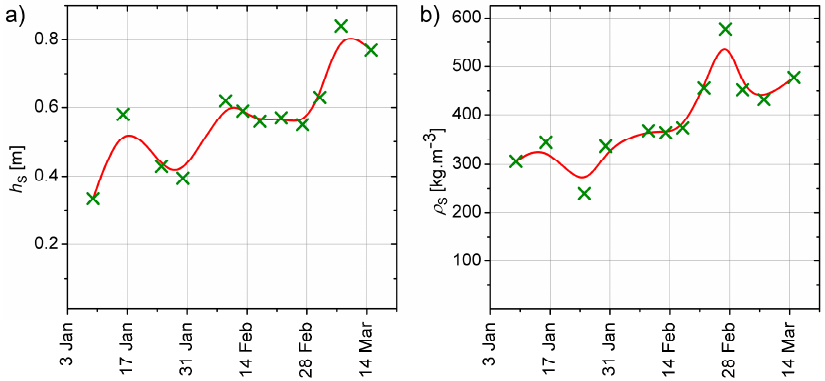
Figure 2. ( a ) Measured snow height h S , and ( b ) density ρ S of the bottom ~10 cm of the snowpack. Snow melted down in the second half of March, and disappeared within ~10 days (see [22]).